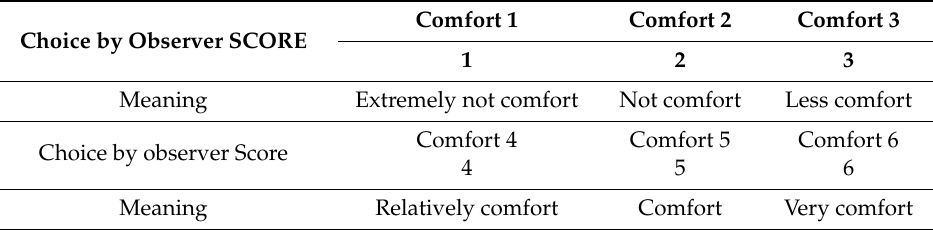
Table 1. An example of scoring (Comfort levels score).